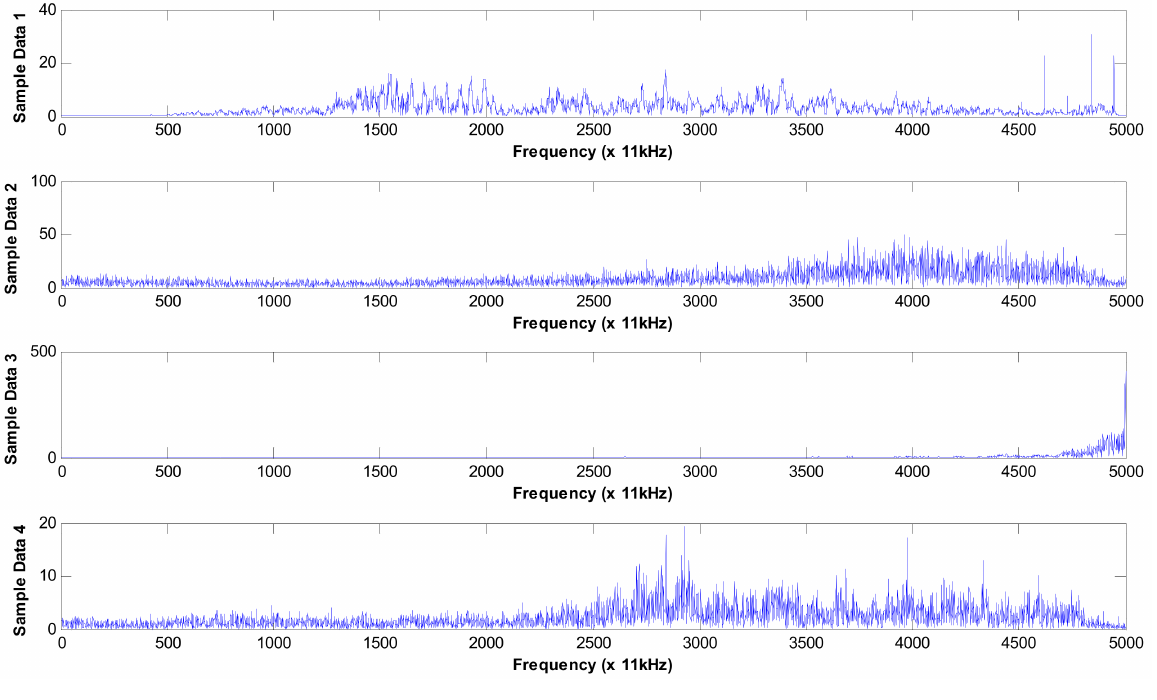
Figure 6. Frequency domain data representation.